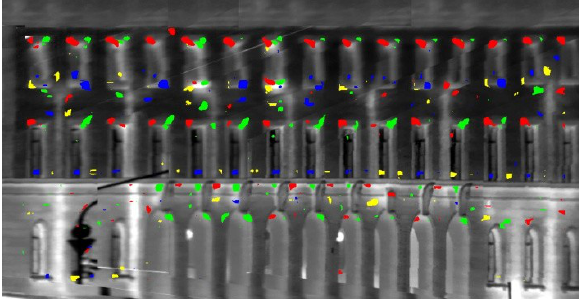
Figure 2. Corners extracted in a thermal façade textures: red - “upper left”, green - “upper right”, blue - “lower right” and yellow - “lower